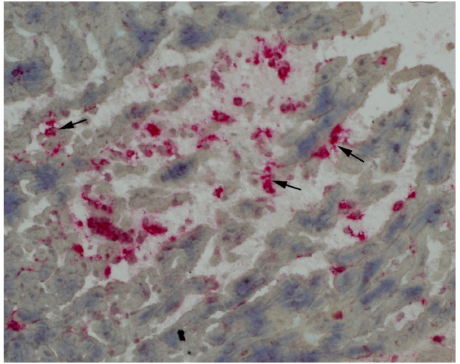
Figure 2. To the best of our knowledge, GPA with the only recurrent symptom being chest pain caused by cardiac involvement has not been reported. In general, clinical signs of cardiac involvement in GPA are rare and commonly associated with coronary artery or pericardial involvement [4]. Echocardiography